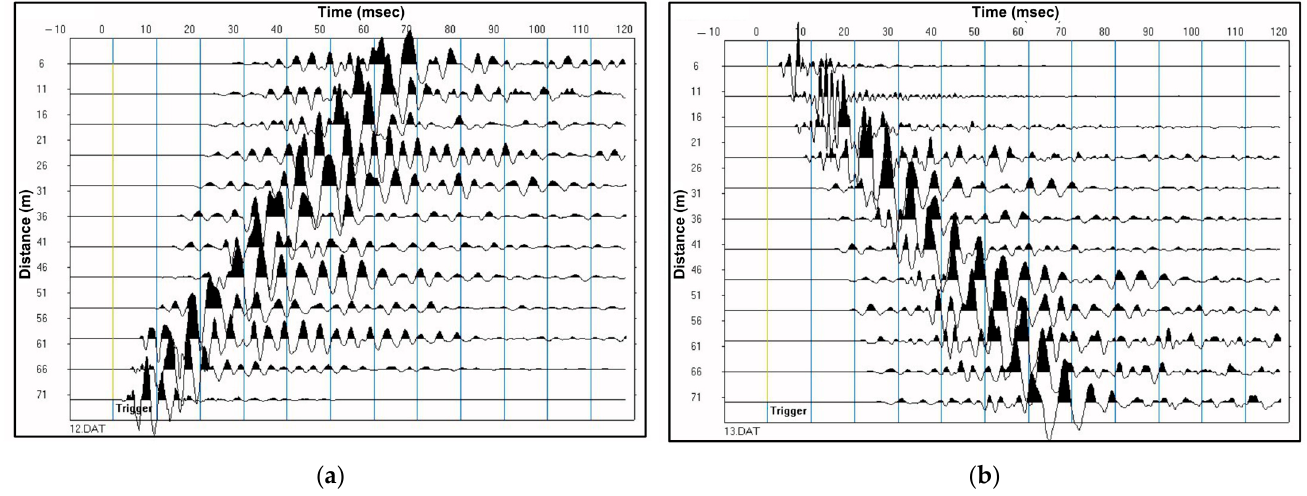
Figure 7. Samples of collected seismic refraction records of the profile SR#11: ( a ) forward shooting and ( b ) reverse shooting.